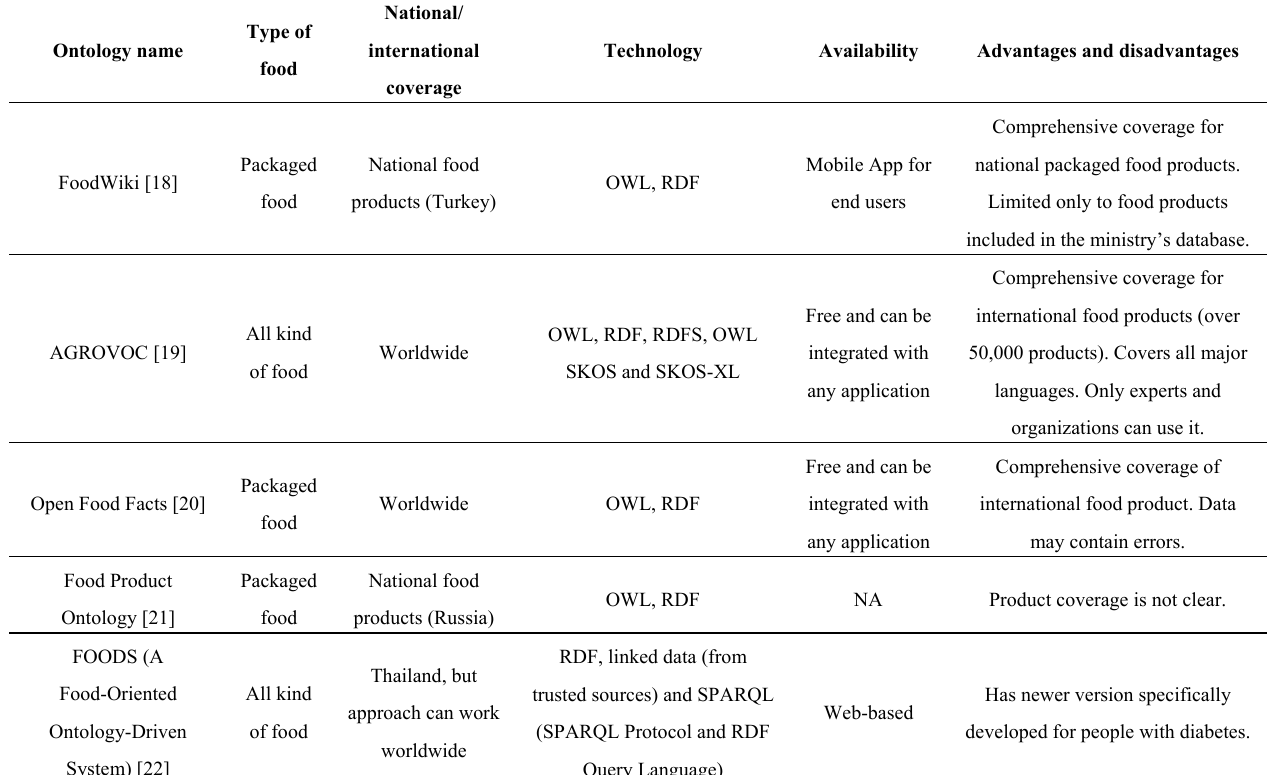
Table 1. Comparison of the studied “food